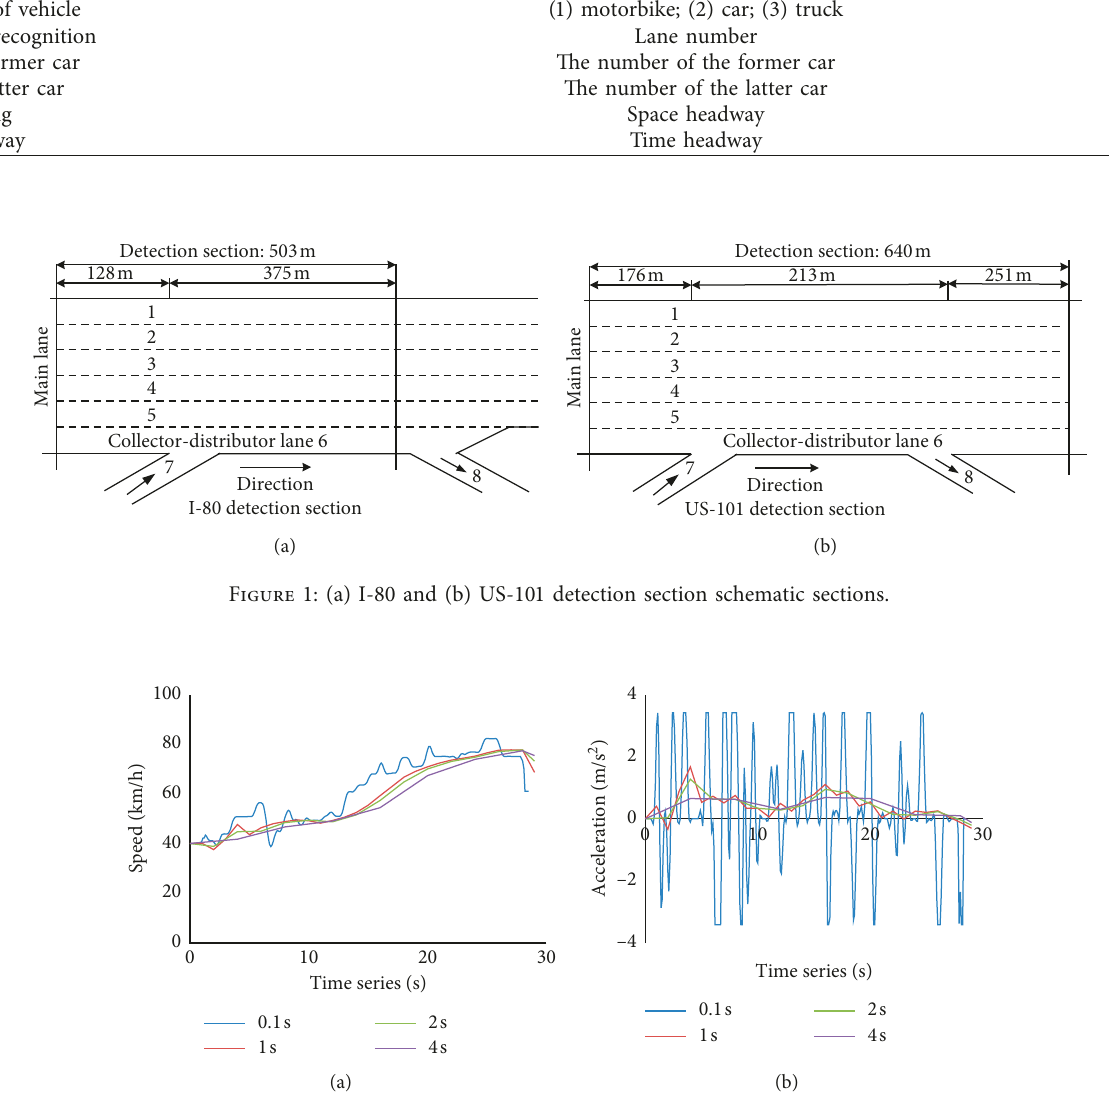
Figure 2: Microcosmic parameter time series